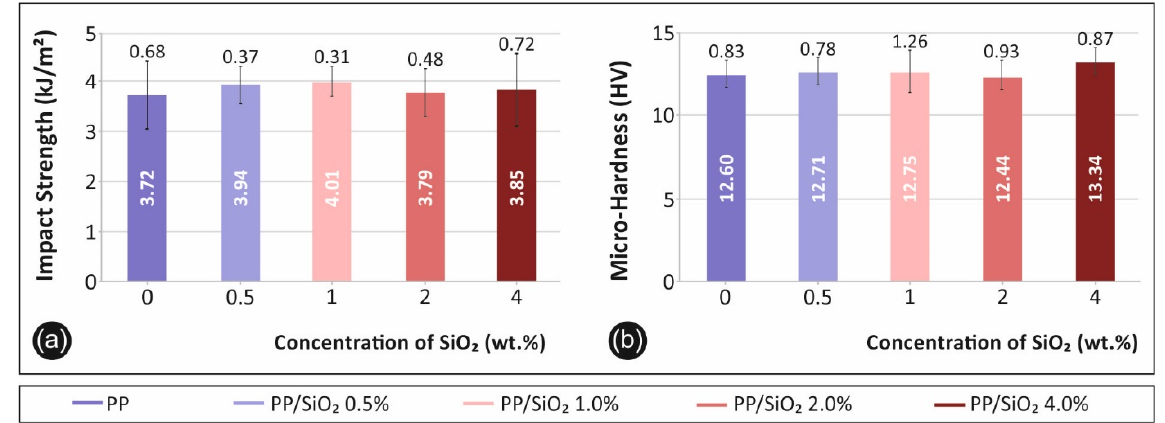
Figure 5. Impact and microhardness test: ( a ) average impact strength (kJ/m 2 ) and its deviation and, ( b ) average microhardness (HV) measurements and their deviations for all materials fabricated in this work.